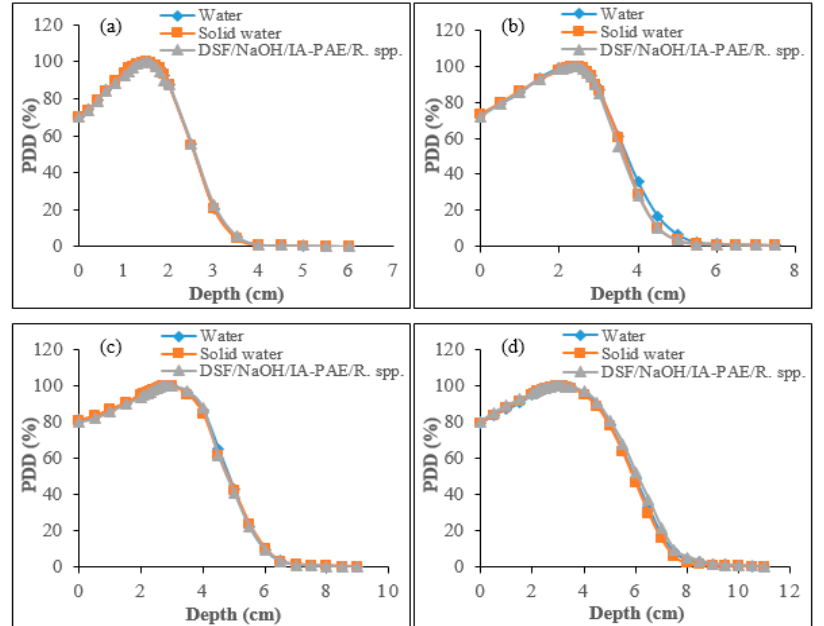
Figure 11. PDD plots for water, solid water, and DSF/NaOH/IA-PAE/ R. spp. particleboard phan-